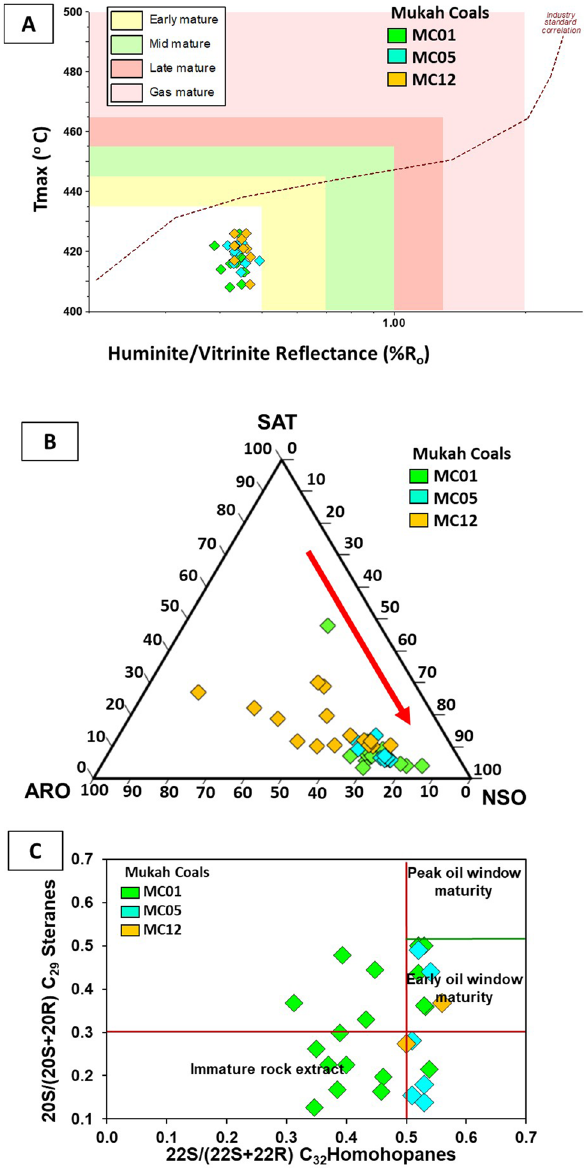
Figure 10. Diagrams illustrate ( A ) T max versus huminite/vitrinite reflectance measurement (%Ro), ( B ) ternary diagram of saturates (SAT), aromatic (ARO) and NSO compound and ( C ) cross plot of 20S/(20S + 20R) C 29 steranes against 22S/(22S + 22R) C 32 homohopanes, showing their distribution and the thermal maturity level of the studied Mukah coals